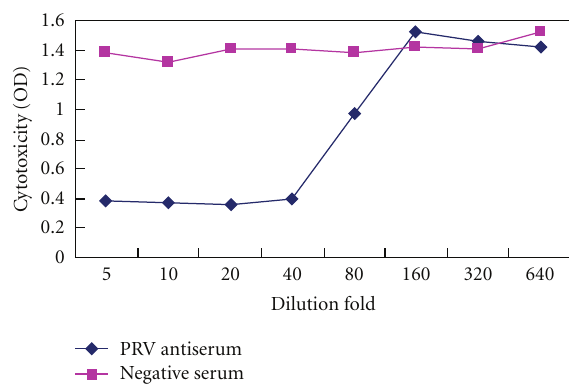
Figure 6: MA104 cells were infected with porcine rotaviruses (PRV) at a dose of 100 TCID 50 in the presence of serial dilutions of anti- PRV antiserum or a negative serum. Anti-PRV antibodies inhibited cytopathicity in a dose-dependent manner. In contrast, the control serum could not inhibit virus induced